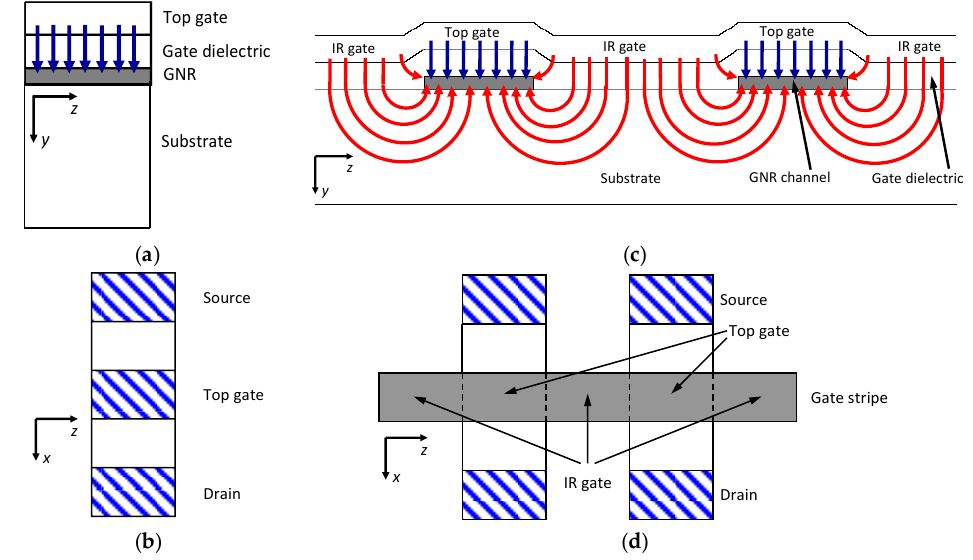
Figure 4. Cross section and top view of a single-channel GNR MOSFET with top gate only and of a multiple-channel GNR MOSFET with interribbon gate. ( a ) Cross section of a single-channel GNR MOSFET in the y - z plane. ( b ) Top view of the single-channel GNR MOSFET from ( a ). ( c ) Cross section of a multiple-channel MOSFET with two parallel GNR channels and IR (interribbon) gate in the y - z plane. ( d ) Top view of the multiple-channel GNR MOSFET from ( c ). Note that in Figure 4a,c the current flows perpendicular to the paper plane.